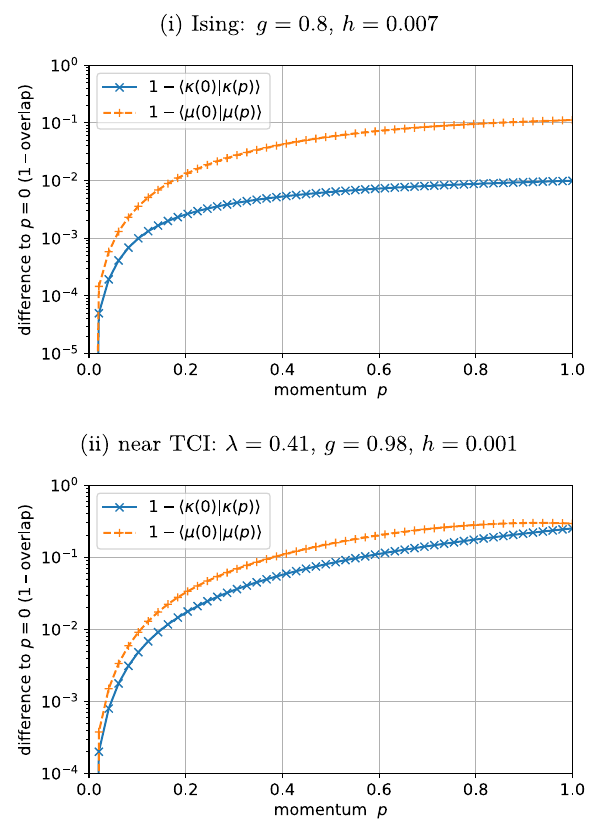
FIG. 13. Error made [1 − (cid:2) φ j ( B ) | φ j { B ( p ) }(cid:3) ] in ignoring the momentum dependence of the tensor B used to construct MPS quasiparticle states, for both kink and meson excitations, for the Hamiltonian parameters used in simulations (i) and (ii) of the main text. The momentum-eigenstate freedom on B ( p ) is fixed so that (cid:2) φ j ( B ) | φ k ( B (cid:15) ) (cid:3) = δ jk